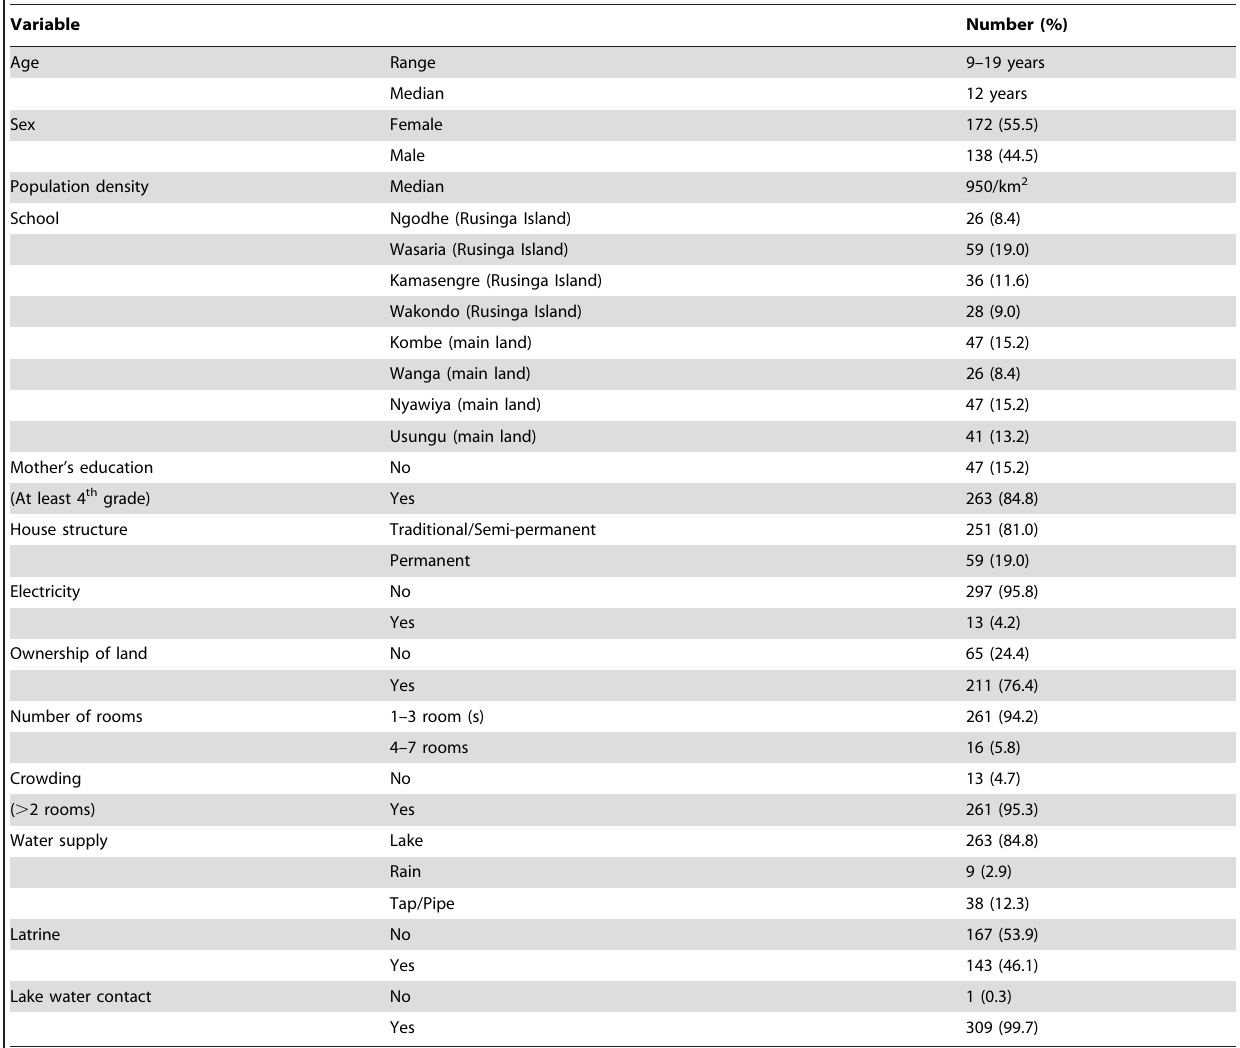
Table 1. Potential risk factors of Schistosoma mansoni